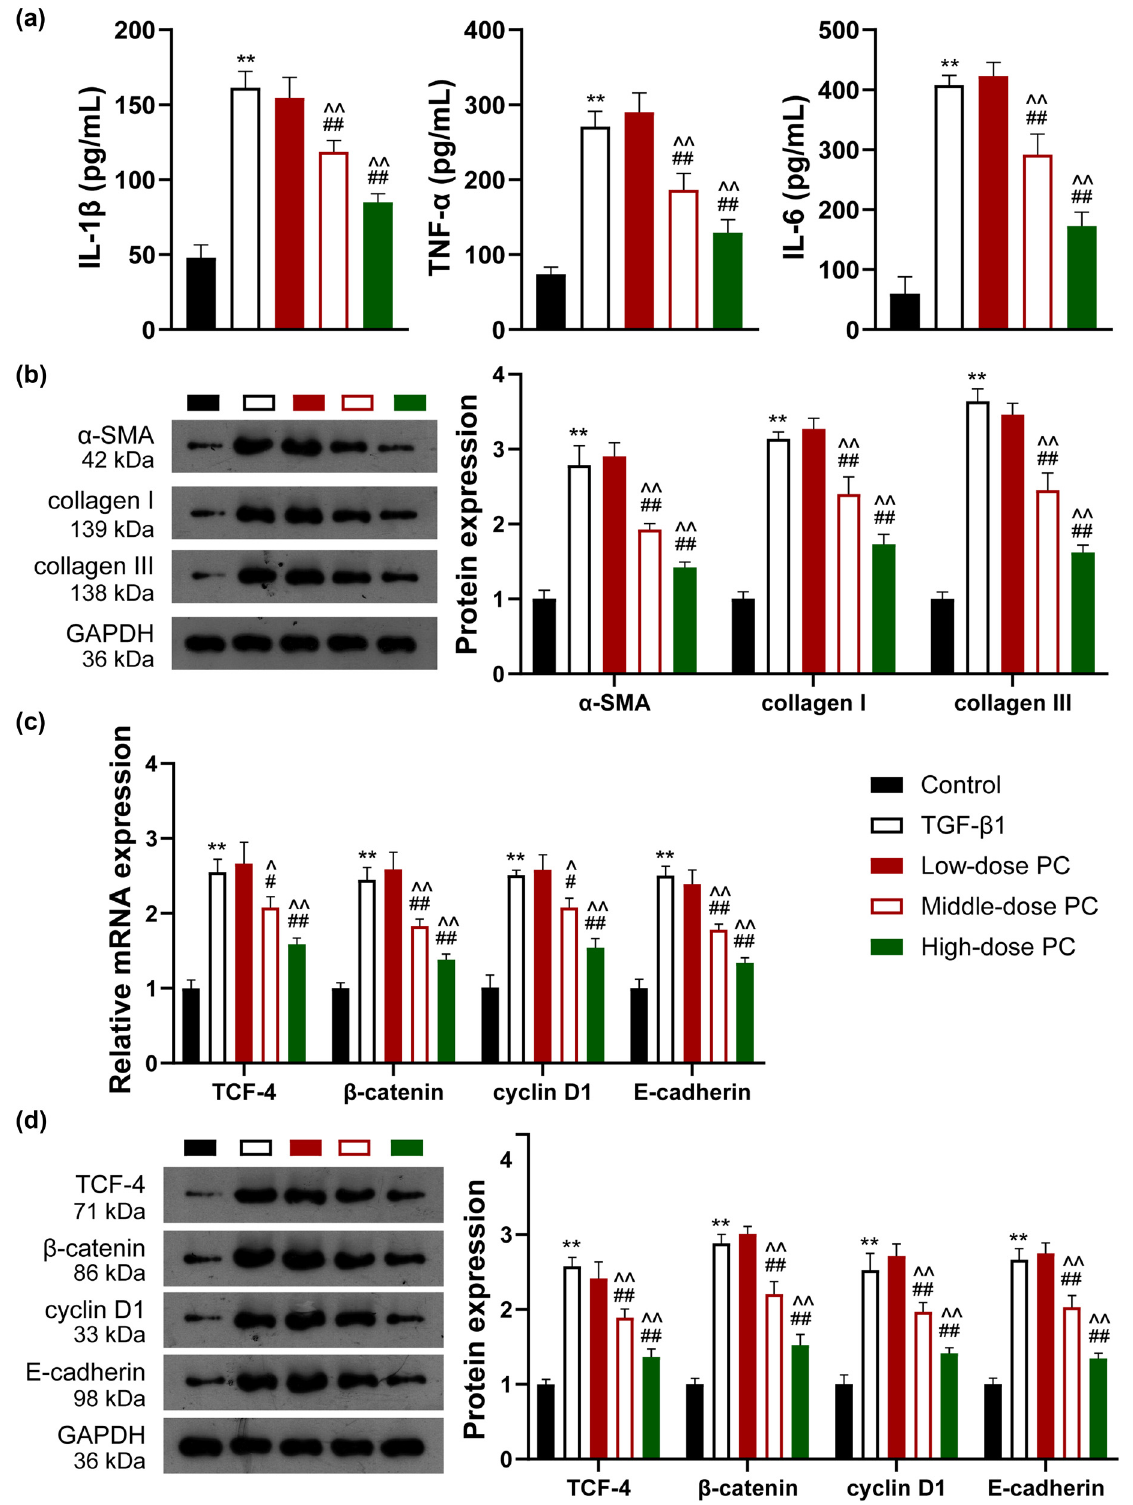
Figure 4: PC reduces fi brosis and Wnt/ β - catenin pathway activation in HFL - 1 cells. ( a ) The expression of in fl ammatory factors IL - 1 β , TNF - α , and IL - 6 was quanti fi ed by ELISA. ( b ) The levels of α - SMA, collagen I, and collagen III in HFL - 1 cells were detected by western blot. ( c and d ) The expression of TCF - 4, β - catenin, cyclin D1, and E - cadherin in HFL - 1 cells was analyzed by RT - qPCR and western blot assays. The HFL - 1 cells were stimulated by TGF - β 1 for 24 h and cultured in the medium with di ff erent dose of prepared drug containing serum ( 5, 10, and 20% ) . ** P < 0.01 vs control, # P < 0.05 and ## P < 0.01 vs TGF - β 1, ^ P < 0.05 and ^^ P < 0.01 vs low - dose